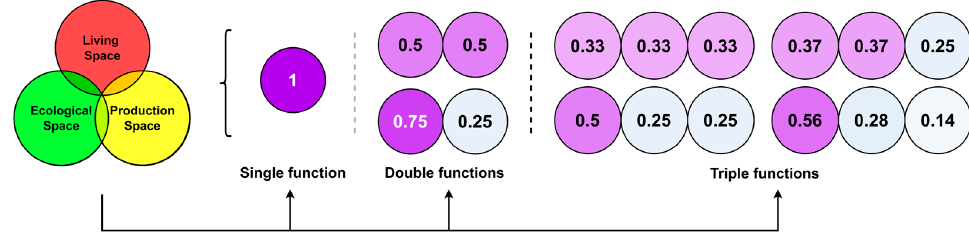
Figure 2. Schematic diagram of functional grade assignment of Production-living-ecological space.